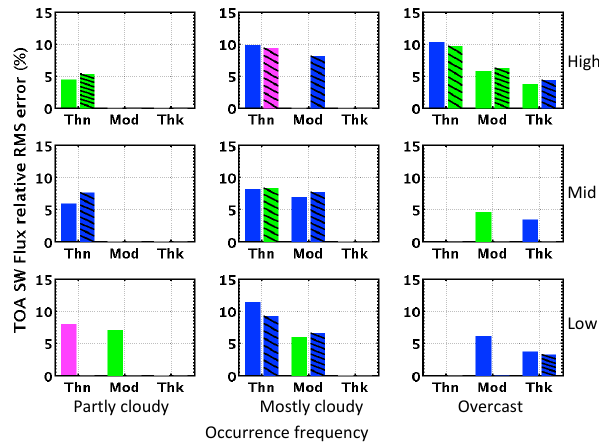
Figure 7. Same as Fig. 6, but over land.